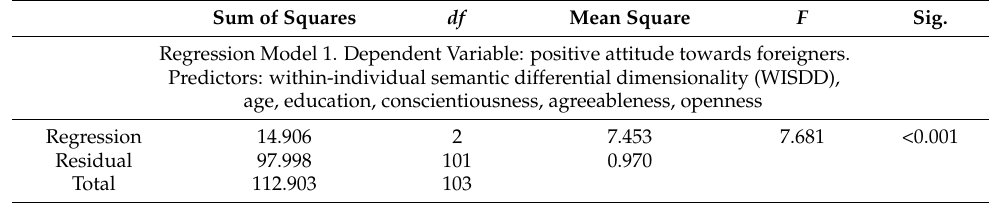
Table 1. Regression models. ANOVA test. Sum of Squares df Mean Square F